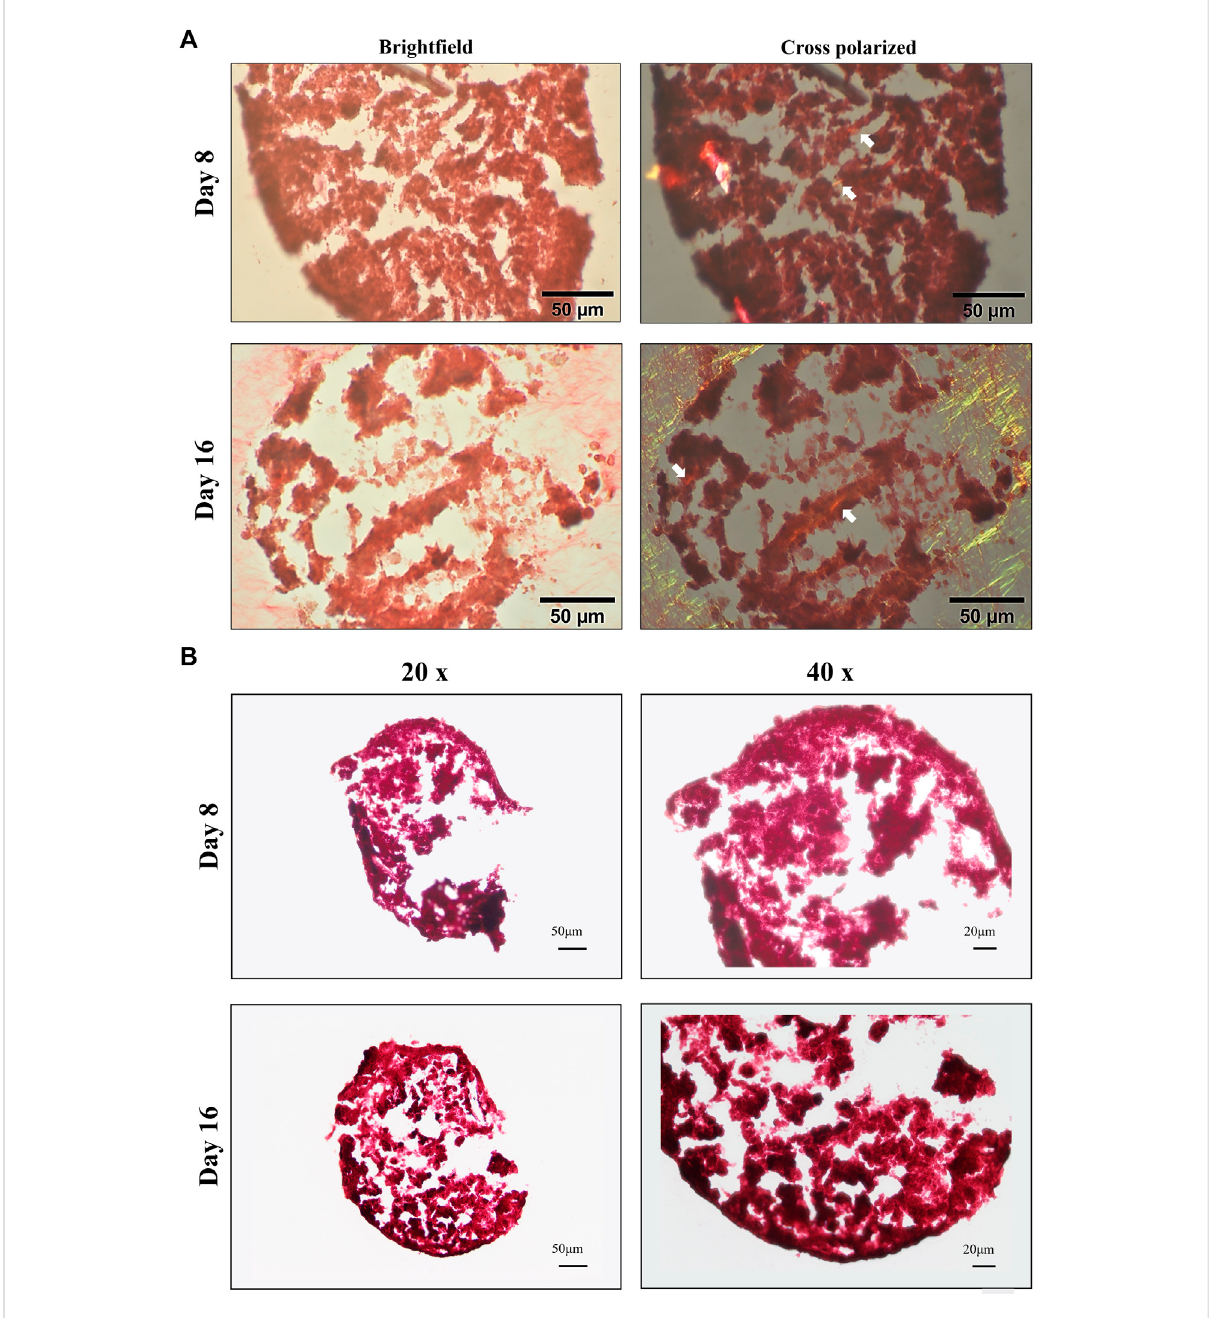
FIGURE 8 Bright fi eld and cross-polarized images of picrosirius red (A) and Safranin-O (B) staining on 3D high density culture at days 8 and 16. Fine birefringent collagen fi bers were visible by day 8 and day 16 (see white arrows) in BM culture. Scale bar: 50 µm (A) ; accumulation of acid proteoglycans (stained in red) after 8 and 16 days in WJ-3D culture. Scale bar 20 µm (B)